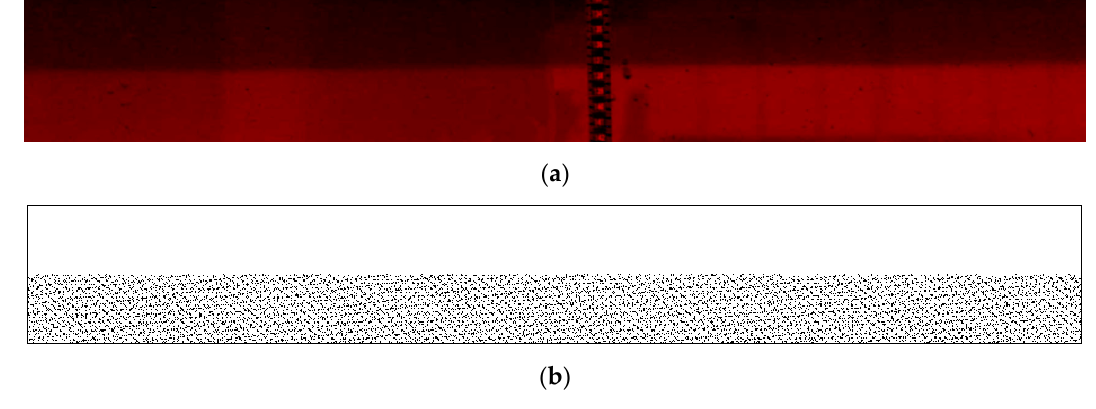
Figure 5. Lateral photograph of a salt-fresh water interface which was steady and smooth at the moment of high water. ( a ) Processed image in which the red color represents the brine. In a general way, the brighter the red color is, the higher the salinity is (similarly hereinafter). ( b ) Schematic diagram of Figure 4(a) for clear description.